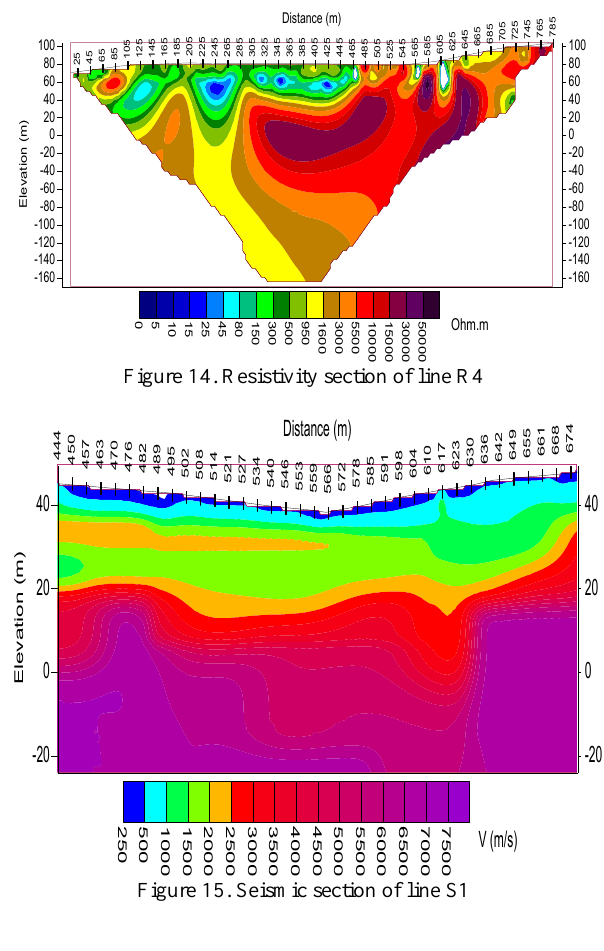
Figure 15. Seismic section of line